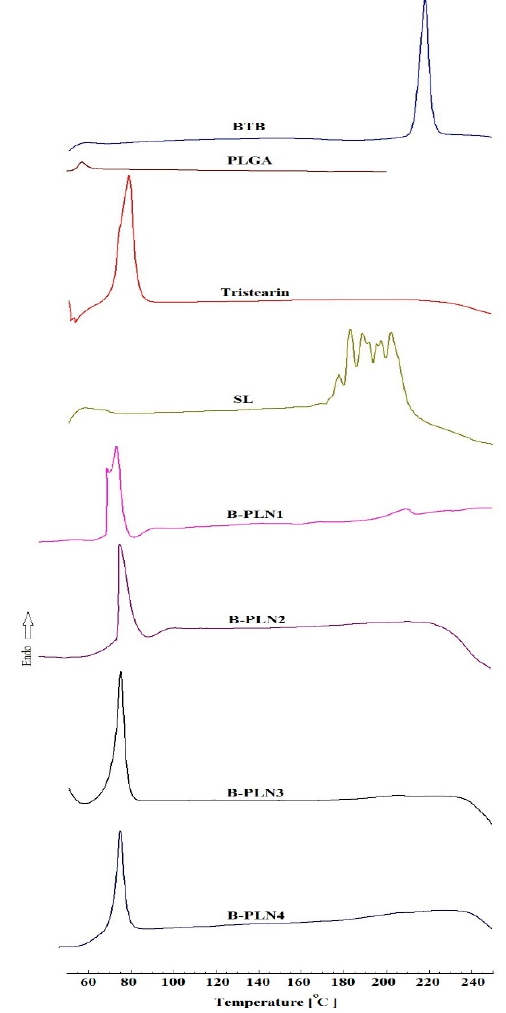
Figure 1. Comparative DSC thermograms of BTB, PLGA, stearin, SL and formulated lipid-polymer nanoparticles (B-PLN1 to B-PLN4). nanoparticles (B-PLN1 to